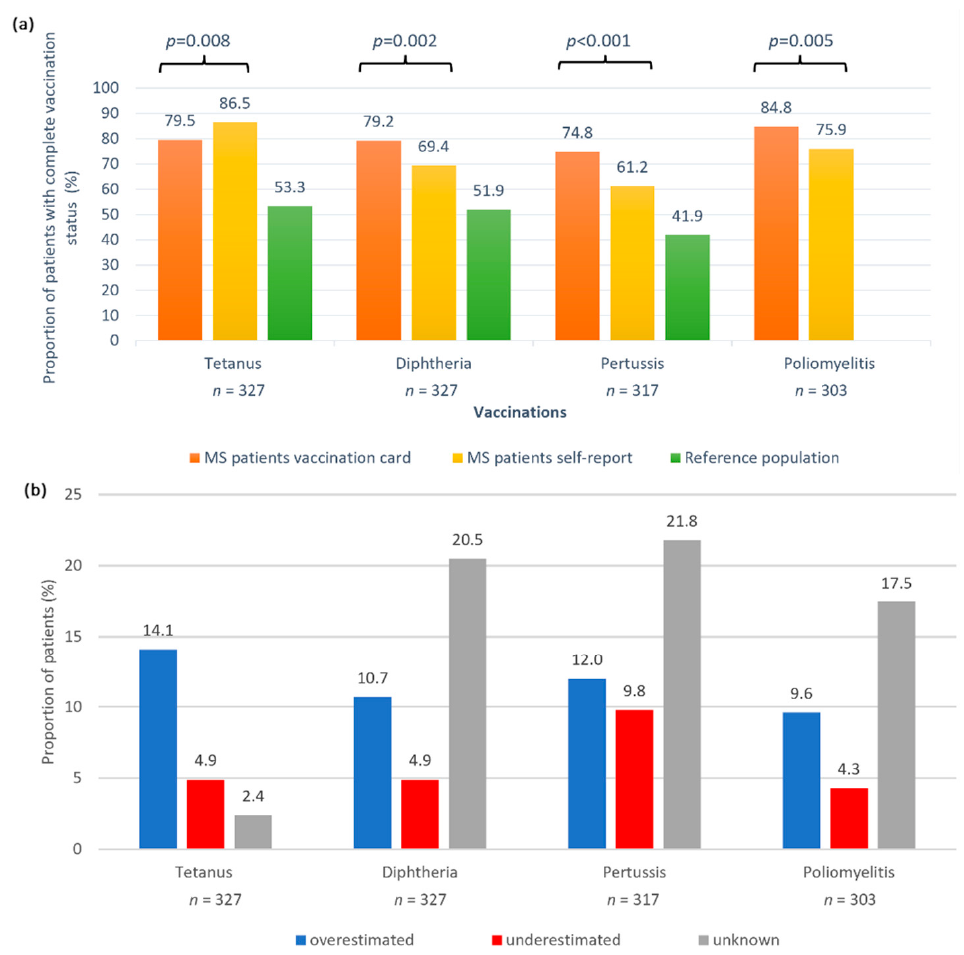
Figure 1. Concordance of self-reported vaccination status and vaccination card information in pa- tients with MS. ( a ) There was a significant difference in immunization status as documented in the vaccination cards (orange bars) and as assumed by the patients (yellow bars). More patients with MS thought they were fully vaccinated against tetanus than was actually the case ( p < 0.008 McNemar ). In contrast, for the other vaccinations, the assumed vaccination status was lower than the docu- mented vaccination rates: more patients were actually fully vaccinated than the self-reports indicated ( p ≤ 0.005 McNemar ). Vaccination rates were markedly higher than for the general population in Germany (no data on polio vaccines were available) [34]. ( b ) More patients overestimated vaccination completeness than underestimated it. The proportion of patients who reported not knowing their vac- cination status was 2.4% for tetanus and roughly 20% for the other vaccinations under consideration. McNemar —McNemar’s test; MS—multiple sclerosis; n —number of patients; p — p -value.